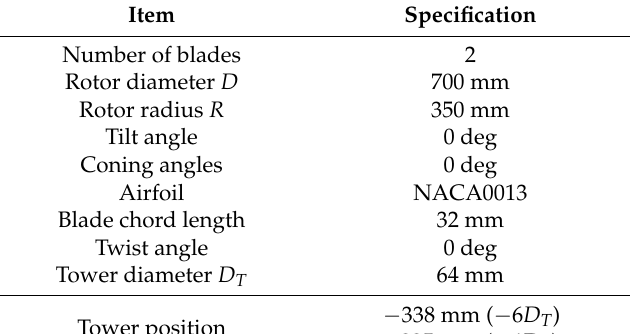
Table 1. Specifications of the test model and the dummy tower.